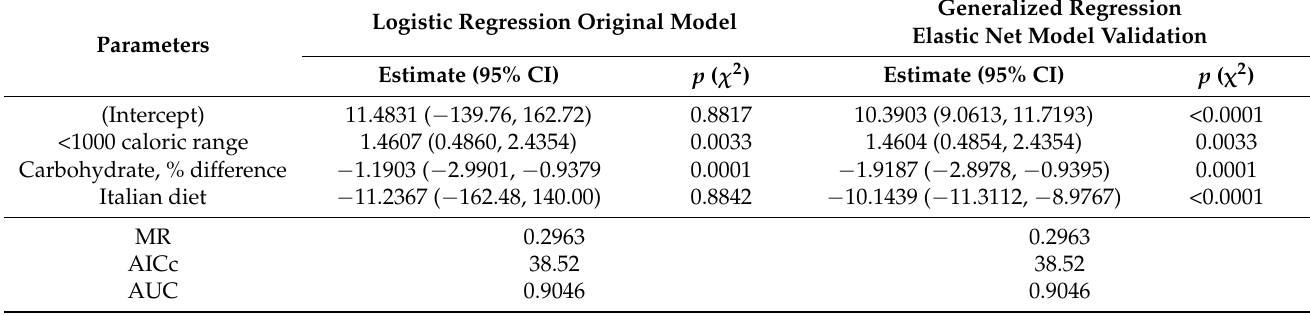
Table 4. Significant factors contributing to the differences between internet-based application against Nutrition Data System for Research on folate.